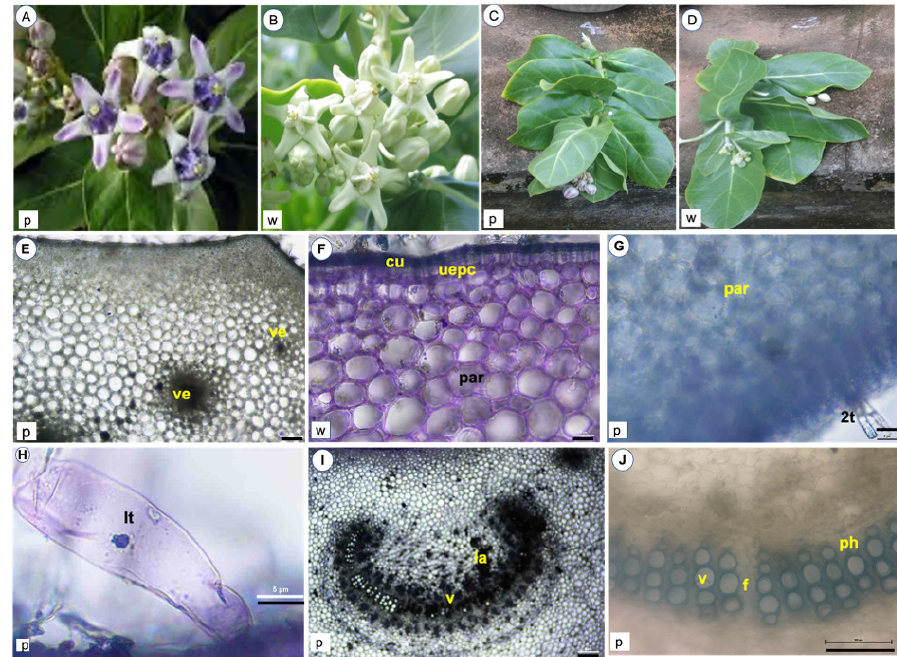
Figure 1 : Gross morphological and petiole anatomical characters of purple and white-coloured forms of Calotropis gigantea . (A) flowers of purple-coloured form. (B) floral morphological characters of white-coloured form. (C) vegetative parts of the purple- coloured form. (D) vegetative parts of the white-coloured form. (E) TS of the petiole of purple form showing the two lateral bundles above the main vascular bundle. (F) the upper epidermis shows a clear thick cuticle with trichomes, the cuticle is rich with polyphenols. (G) the lower part of the purple petiole shows the two-celled two trichomes originating from the same place. (H) leaf-like trichome. (I) structure of the vascular system. (J) arrangement of the vessel elements. Sub-figure letters: p: purple. w: white. Abbreviations used: cu: cuticle. f: fiber. lt: leaf-like trichome. par: parenchyma. ph: phloem. uepc: upper epidermal pavement cells. v: vascular bundle. ve: vein. 2t: two trichomes originated from a single place. Scale bar: 5 µm: D, E, F, H; 100 µm: